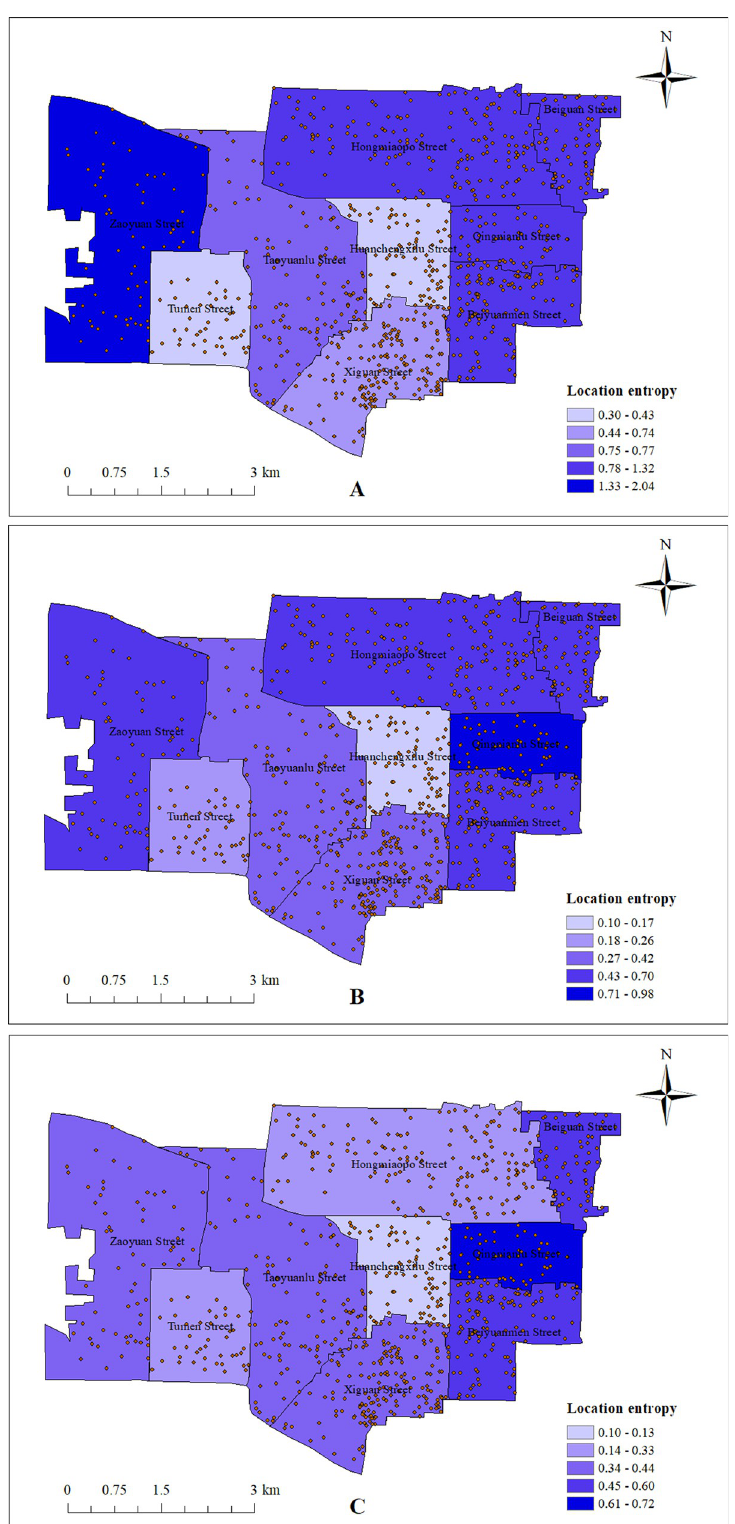
Fig 11. Location entropy of community home care facilities. (A) Location entropy from the perspective of elderly with normal mobility; (B) Location entropy from the perspective of the elderly with mild mobility restriction; (C) Location entropy from the perspective of the elderly with severe mobility restriction. (Self-drawn by the author). https://doi.org/10.1371/journal.pone.0277310.g011 PLOS ONE | https://doi.org/10.1371/journal.pone.0277310 December14,